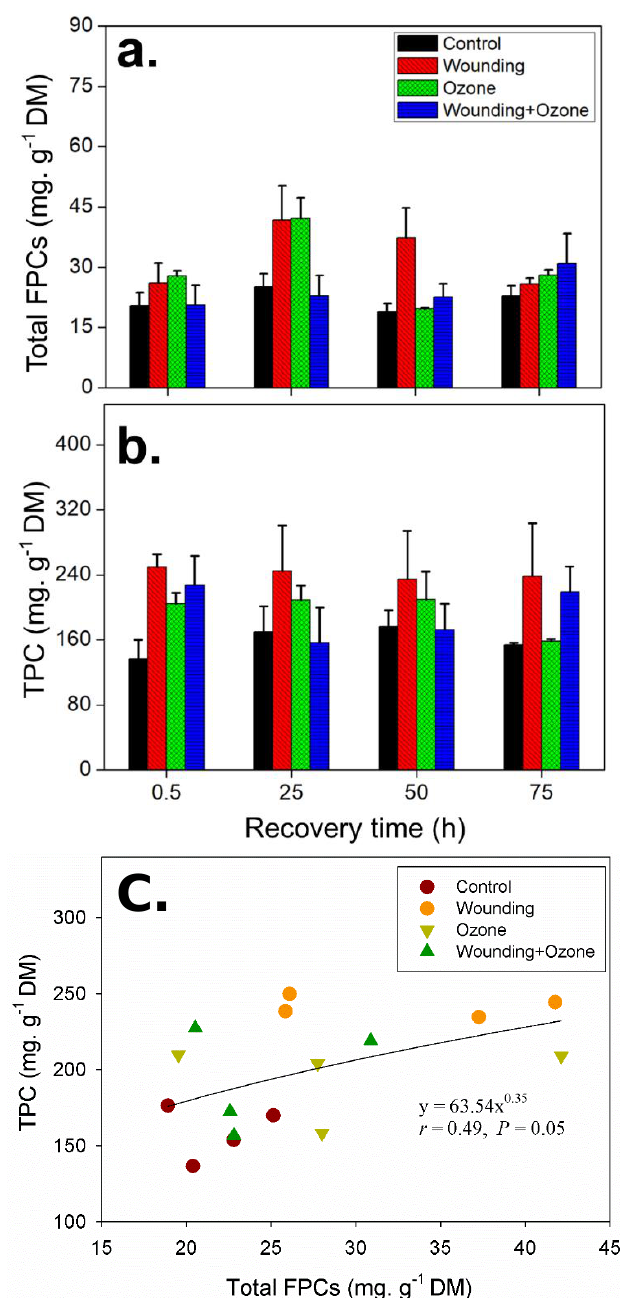
Figure 6. Temporal changes (mean ± SE, n = 3) in the concentration of total FPCs ( a ), total phenolic compounds ( b ), and their correlation ( c ) in E. globulus leaves subjected to separate and combined O 3 and wounding treatments. The data selected for non-linear correlation analysis are the mean of total FPCs and total phenolics concentrations at each recovery time point from different treatments and controls. Total phenolic contents (TPC) are expressed as mg g − 1 DM gallic acid equivalents. Details of the statistical summary are shown in Table 3.